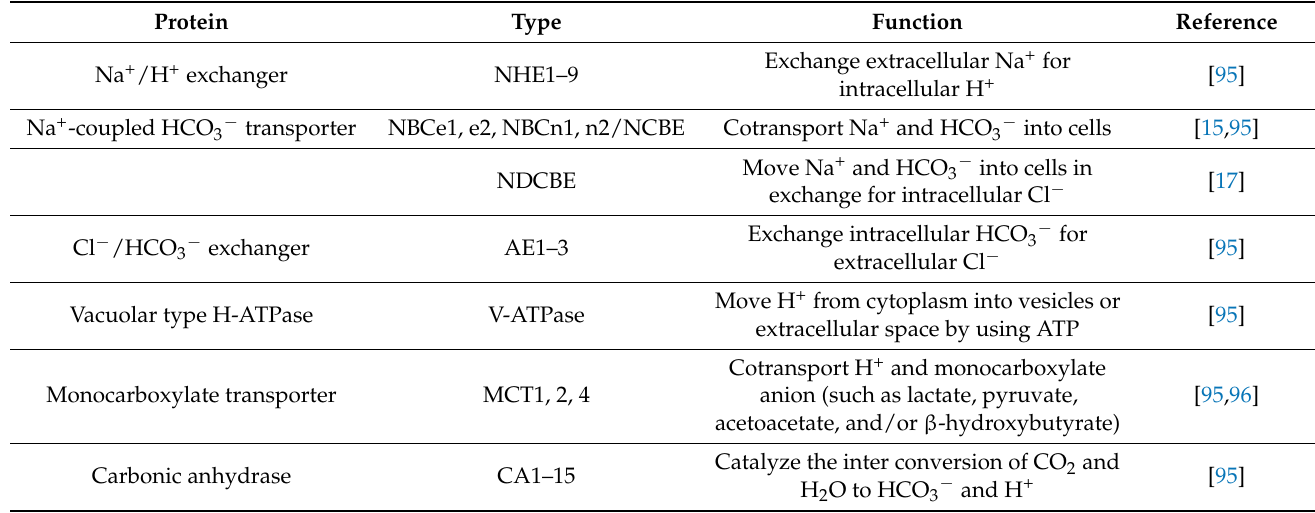
Table 1. Major pH-regulating proteins in the